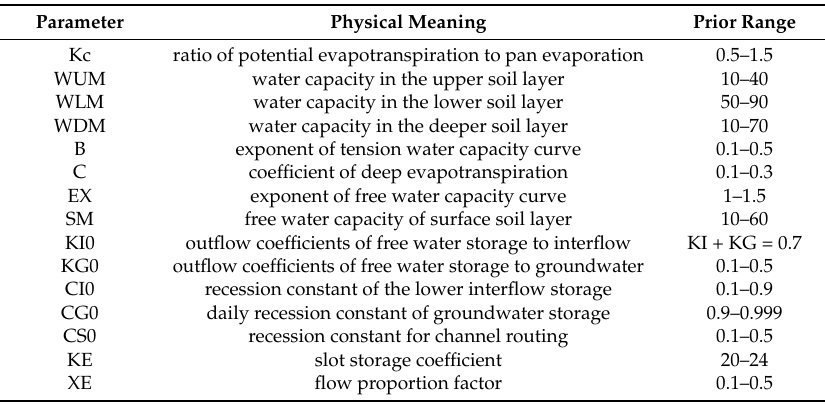
Table 2. Parameters of the XAJ model and their prior